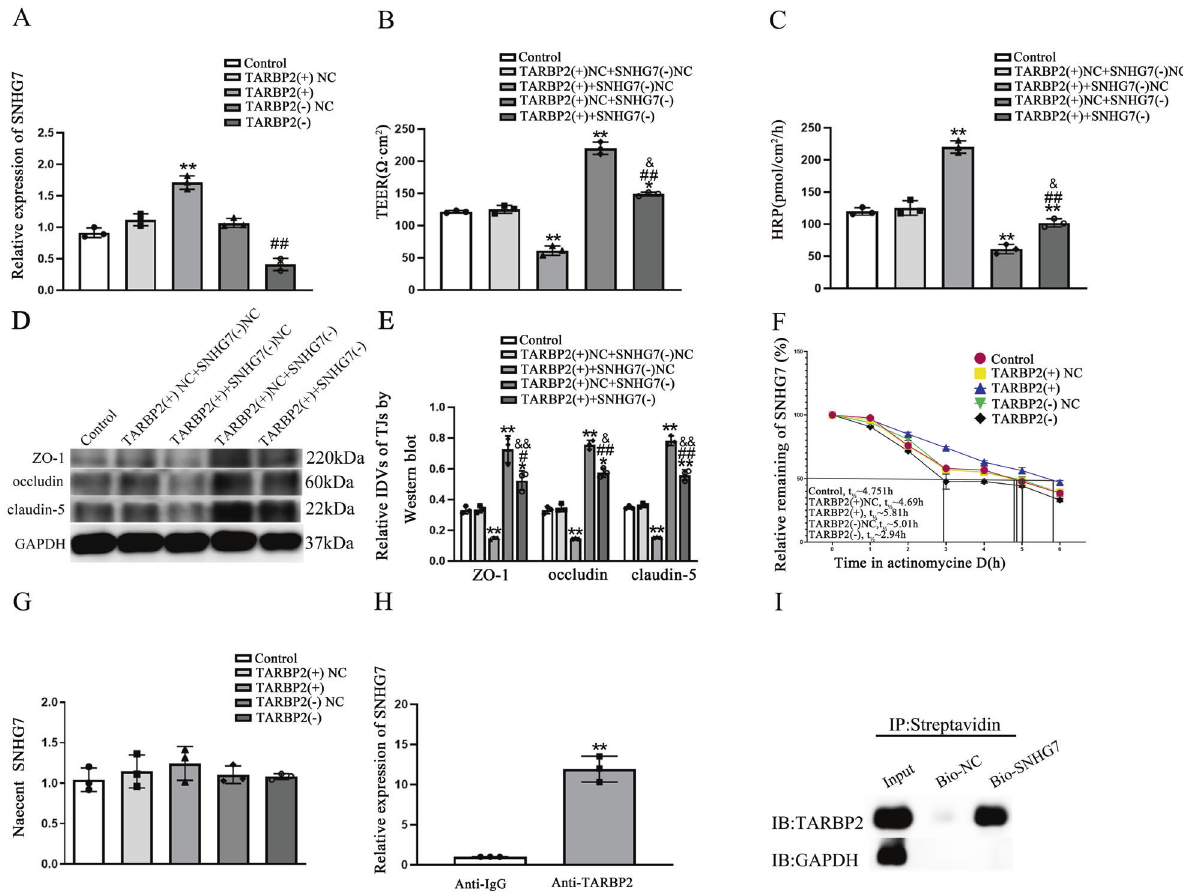
Fig. 4 Binding relationship between SNHG7 and TARBP2 was involved in BBB permeability regulation. A QRT-PCR analysis of SNHG7 expression regulated by overexpression or knockdown of TARBP2 in ECs. **p < 0.01 vs. TARBP2( + )NC group. ## p < 0.01 vs. TARBP2( − )NC group, data were presented as mean ± SD ( n = 3, each). B , C TEER values of BBB were presented as Ω cm 2 . HRP fl ux was measured as pmol/cm2/h. * p < 0.05 and ** p < 0 . 01 vs. TARBP2( + )NC + SNHG7( − )NC group, ## p < 0.01 vs. TARBP2( + ) + SNHG7( − )NC group, & p < 0.05 vs. TARBP2( + )NC + SNHG7( − ), data were presented as mean ± SD ( n = 3, each). D , E The relative expression levels of ZO-1, occludin and claudin-5 were measured by western blot. GAPDH protein levels were performed as an endogenous control. * p < 0.05 and ** p < 0.01 vs. TARBP2( + )NC + SNHG7( − )NC group, # p < 0.05 and ## p < 0.01 vs. TARBP2( + ) + SNHG7( − )NC group, & p < 0.05 and && p < 0.01 vs. TARBP2( + )NC + SNHG7( − ), data were presented as mean ± SD ( n = 3, each). F Graphs showed SNHG7 levels at different times treated by ActD in TARBP2( + ) group and TARBP2( − ) group and respective NC group, data were presented as mean ± SD ( n = 3, each). G Nascent RNA capture assays were employed to show nascent SNHG7 in TARBP2( + ) group and TARBP2( − ) group and respective NC group; data were presented as mean ± SD ( n = 3, each), data were presented as mean ± SD ( n = 3, each). H RNA immunoprecipitation assays (RIP) in ECs used TARBP2 antibody to enrich SNHG7. IgG was used as negative controls. ** p < 0.01 vs. Anti-IgG, data were presented as mean ± SD ( n = 3, each). I RNA pull-down was used to con fi